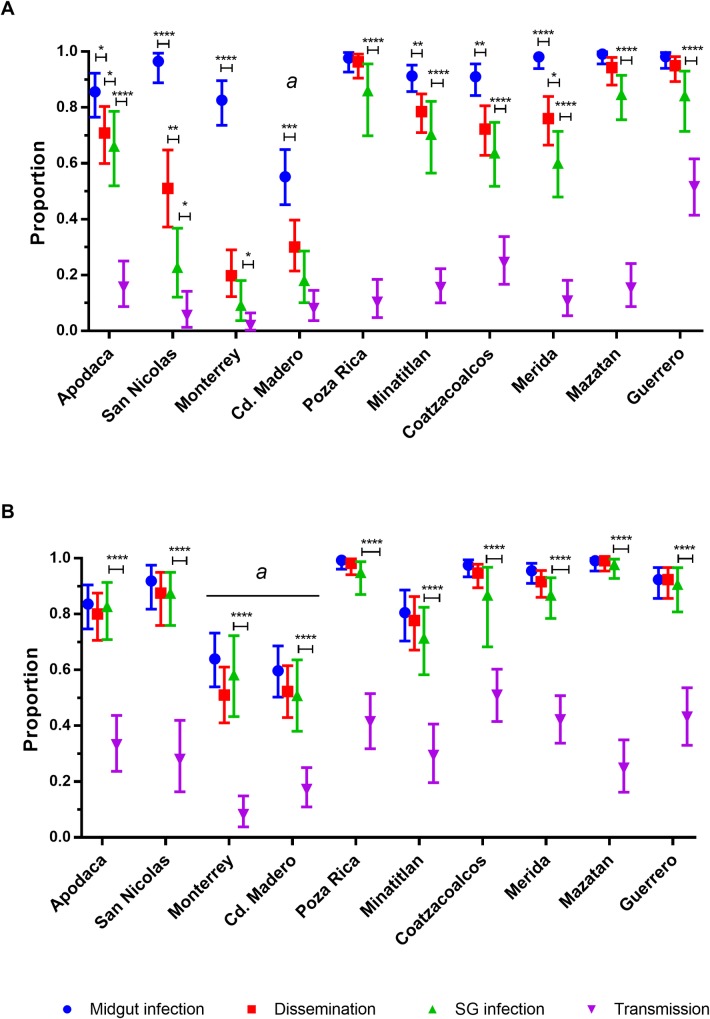
Midgut infection, dissemination, salivary gland infection and transmission rates of Ae. aegypti by collection.A) rates at 7 dpi and B) 14 dpi by collection location. Apodaca is the furthest northern collection while Guerrero is the furthest south. Error bars represent 95% confidence intervals. Data are from at least 2 independent replicates. Statistical significance is depicted as **** for p <0.0001, *** p<0.001, **p<0.01 and * p<0.05 by two-tailed Fisher’s exact test.